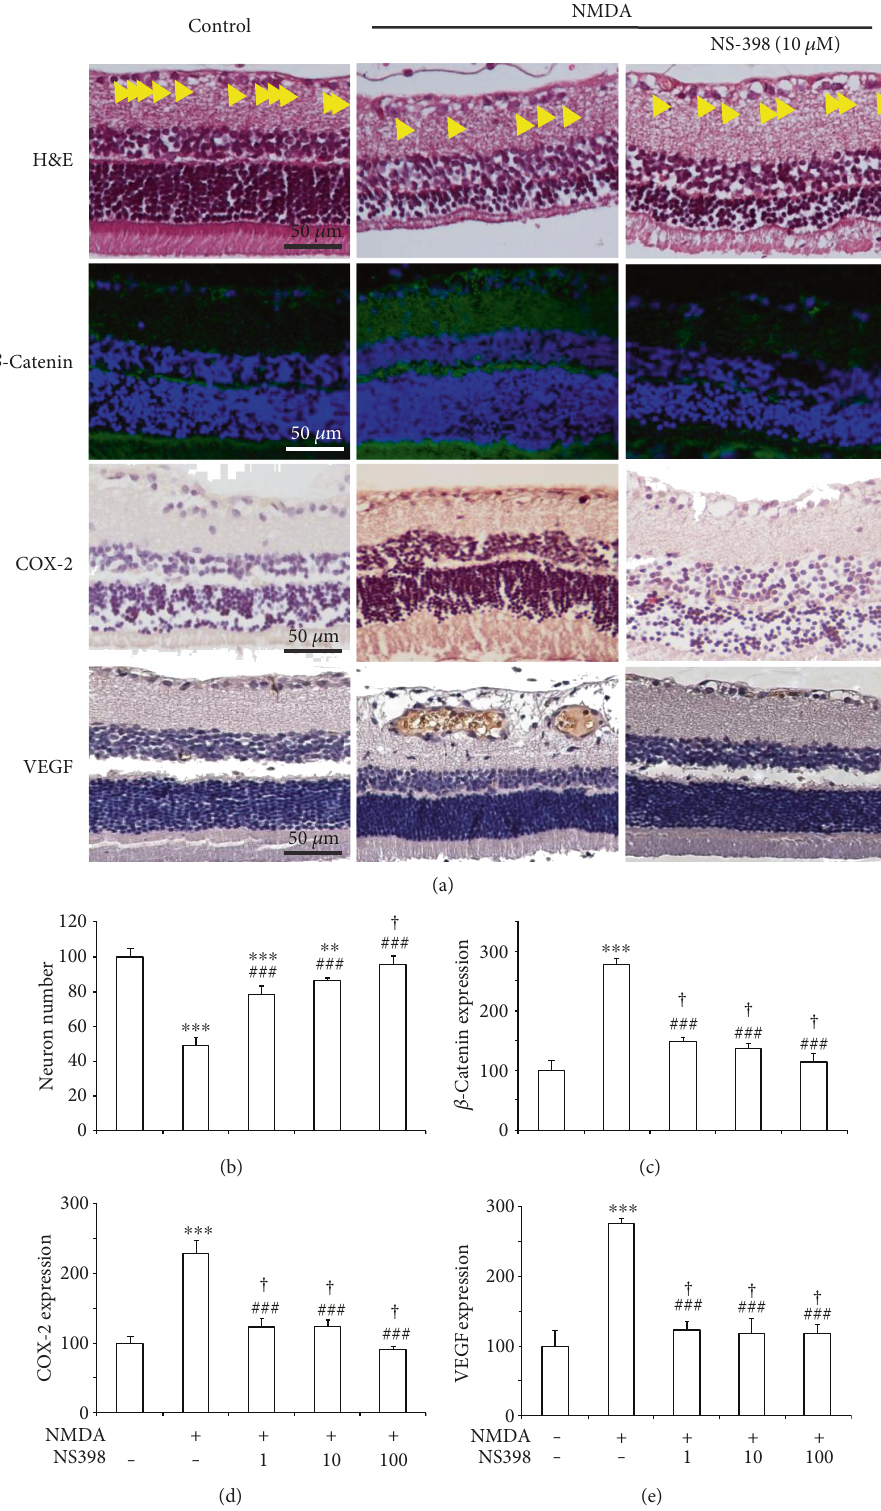
Figure 3: NS-398 could attenuate the NMDA-induced activation of β -catenin causing neuron cell loss. (a) Representative images (H&E staining, expression of β -catenin, COX-2, and VEGF) of the rats. (b) Neuron number of RGCs with respect to control (untreated), in NMDA-injected retinas of animals treated with NS-398. (c) β -Catenin expression of retinas with respect to control in NMDA-injected retinas of animals treated with NS-398. (d) COX-2 expression of retinas with respect to control in NMDA-injected retinas of animals treated with NS-398. (e) VEGF expression of retinas with respect to control in NMDA-injected retinas of animals treated with